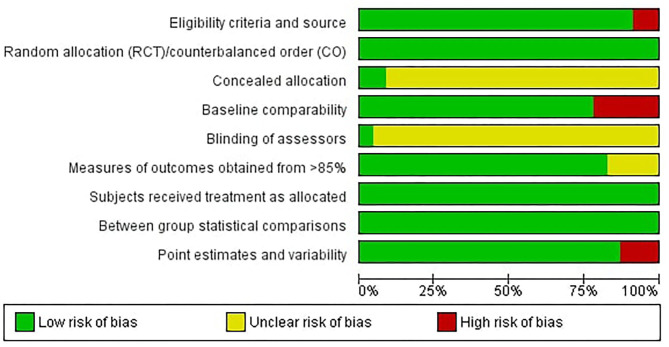
Overview of the PEDro rated study quality (green = low risk of bias, yellow = unclear risk of bias, red = high risk of bias).